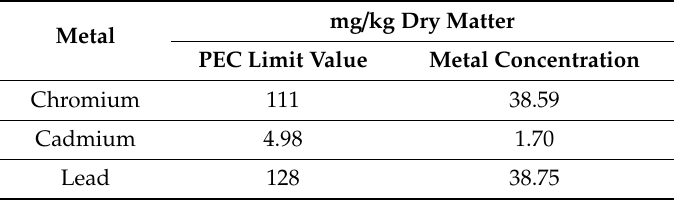
Table 5. Comparison of maximum concentrations of selected heavy metals determined in sediments from the Sulej ó w Reservoir with the values adopted in the classification of bottom sediments on the basis of ecotoxicological criteria